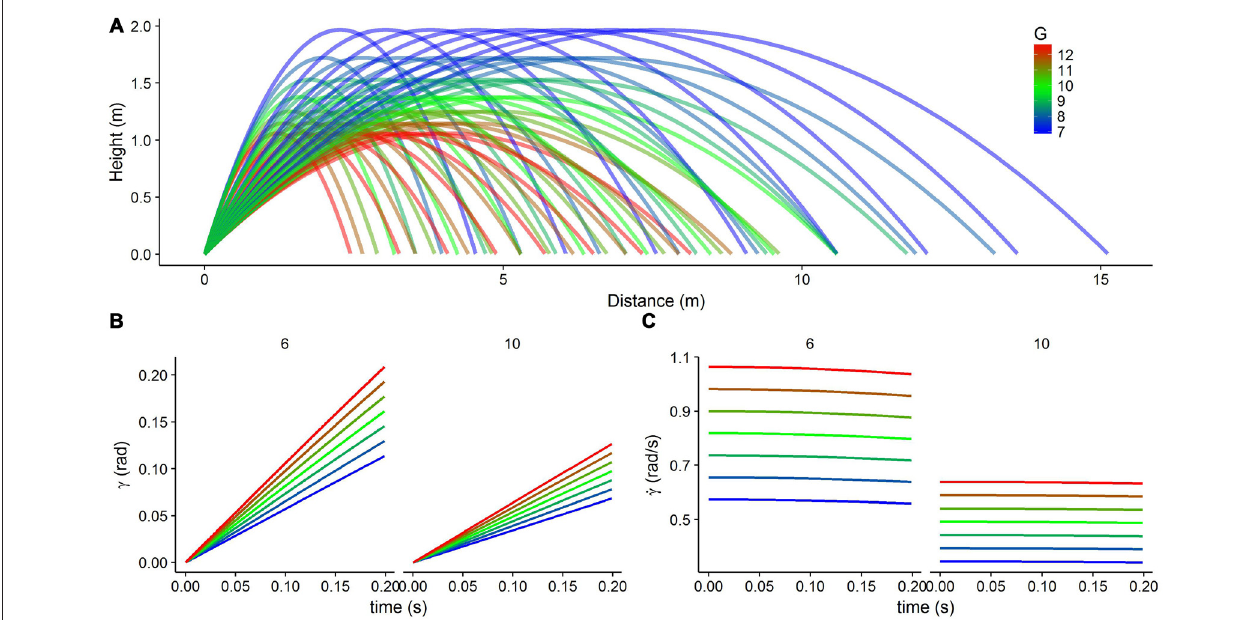
FIGURE 2 | The physical connection between gravity and the optical variables of elevation angle ( γ ) and its temporal rate of change ( ˙ γ ). (A) Parabolic trajectories with different horizontal velocities (from 3 m/s to 10 m/s in steps of 1 m/s) and different gravity values (from 0.7g to 1.3g in steps of 0.1g, color coded from blue to red). (B) The elevation angle ( γ ) as a function of time for different gravities (color coded) and two different horizontal velocities (6 m/s, left, and 10 m/s, right), plotted for the first 200 ms of the trajectory. (C) The temporal rate of change of the elevation angle ( ˙ γ ) as a function of time for different gravities (color coded) and two different horizontal velocities (6 m/s, left, and 10 m/s, right), plotted for the first 200 ms of the